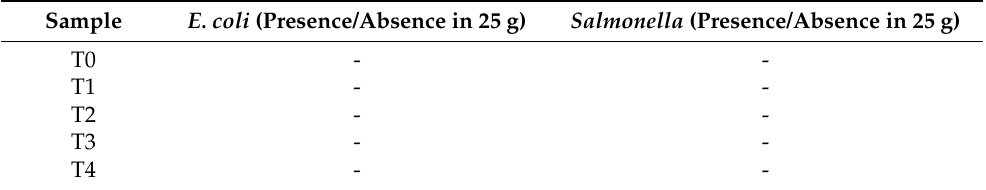
Table 4. Detection of pathogenic bacteria ( E. coli and Salmonella ) in low-salt shrimp paste, qualitatively used as the culture-dependent method.